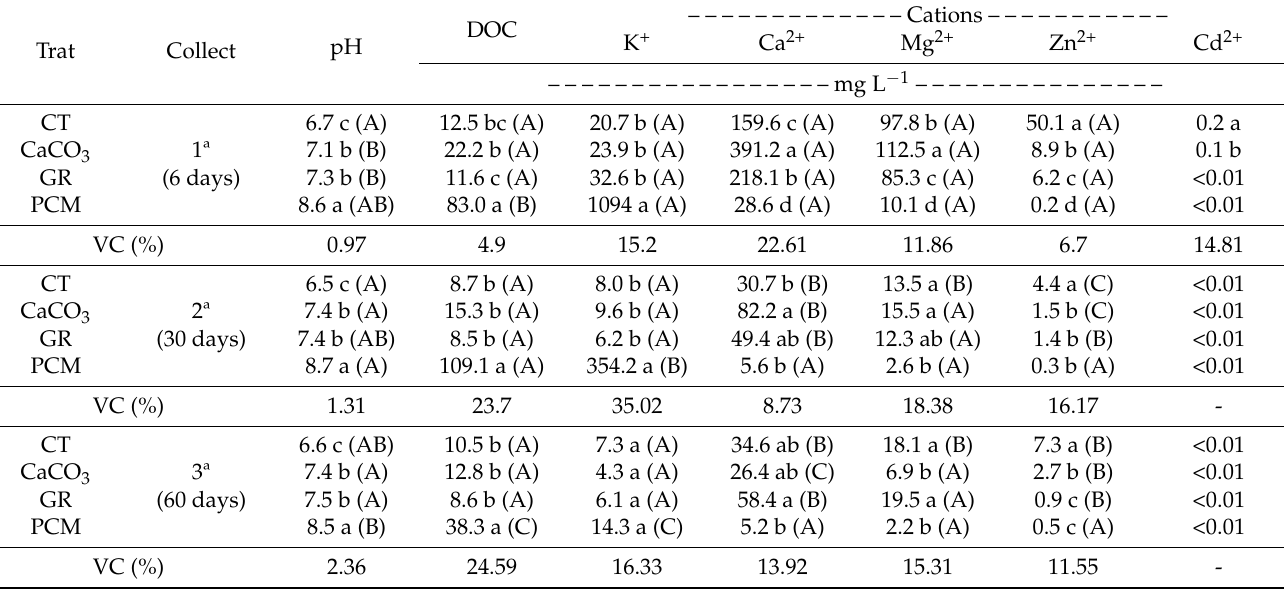
Table 4. Attributes analyzed in the soil solution for the treatments